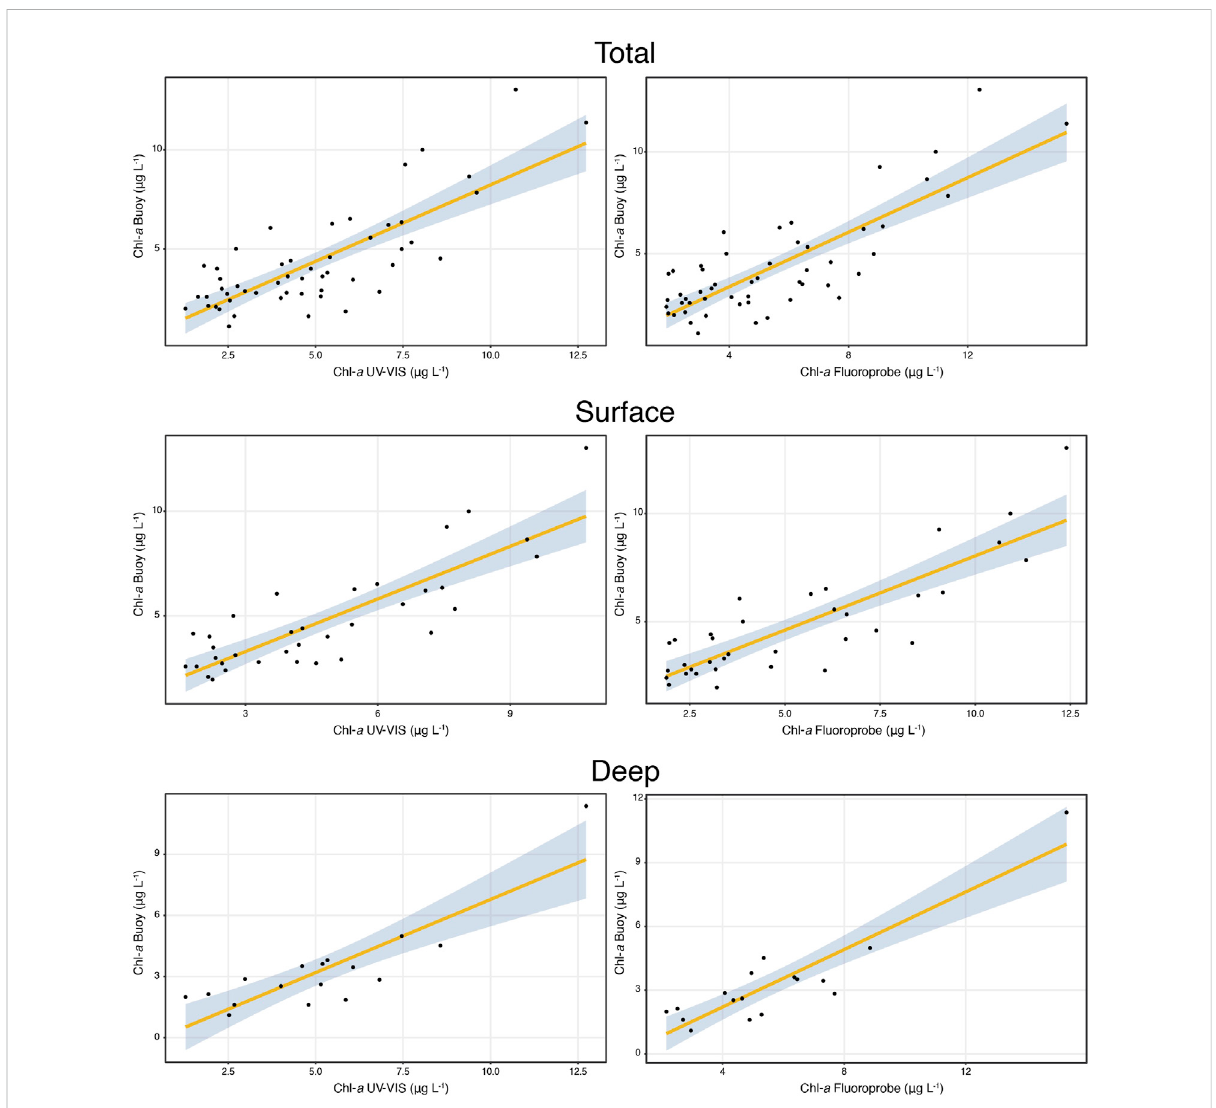
FIGURE 2 Comparison between Chl- a concentrations obtained from the in-situ sensors (buoy) and laboratory analysis UV-VIS (left panels) and FP (right panels). In the panels data are shown for all the samples, surface and deep samples. Statistics of the linear regressions are provided in Table